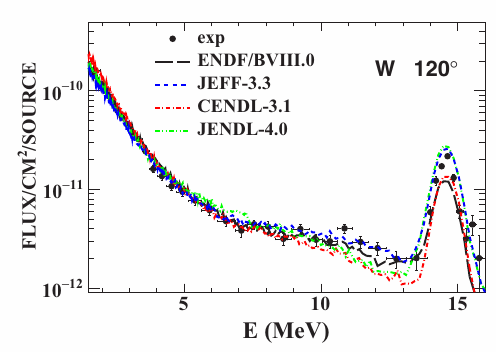
Figure 9. Neutron leakage spectra for W sample at 120 ◦ .